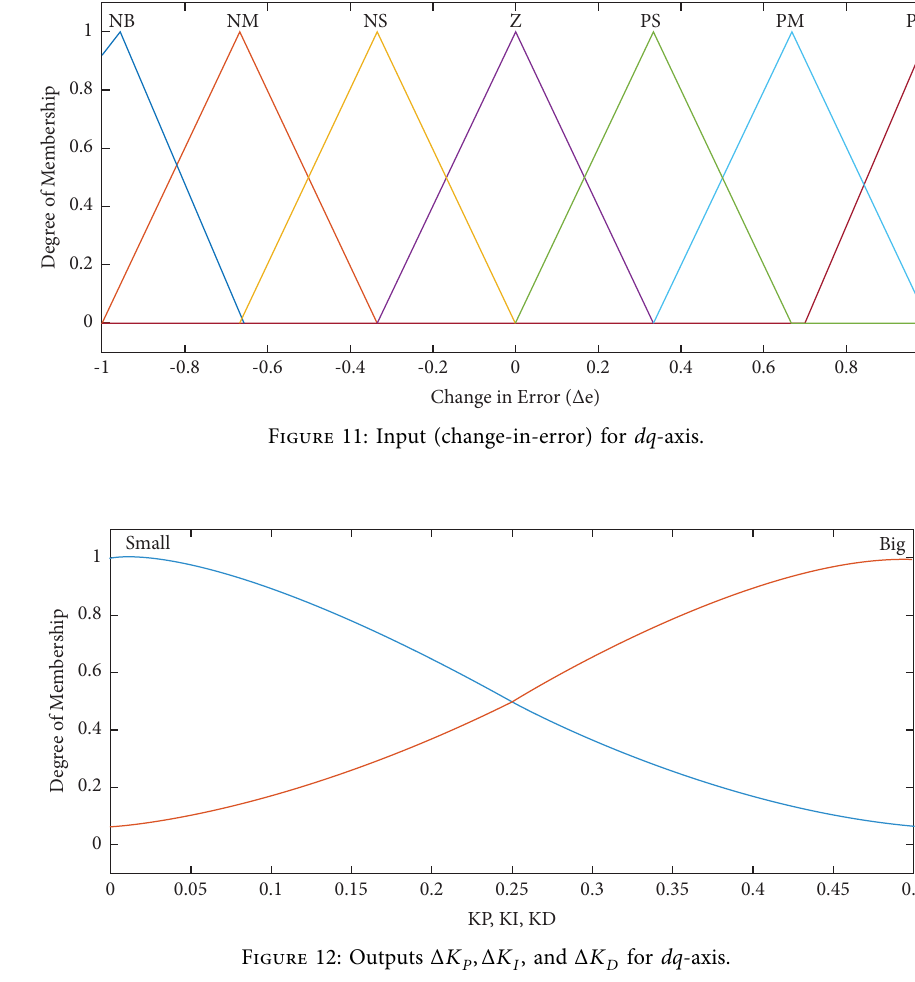
, Δ K K P I , and Δ D for dq